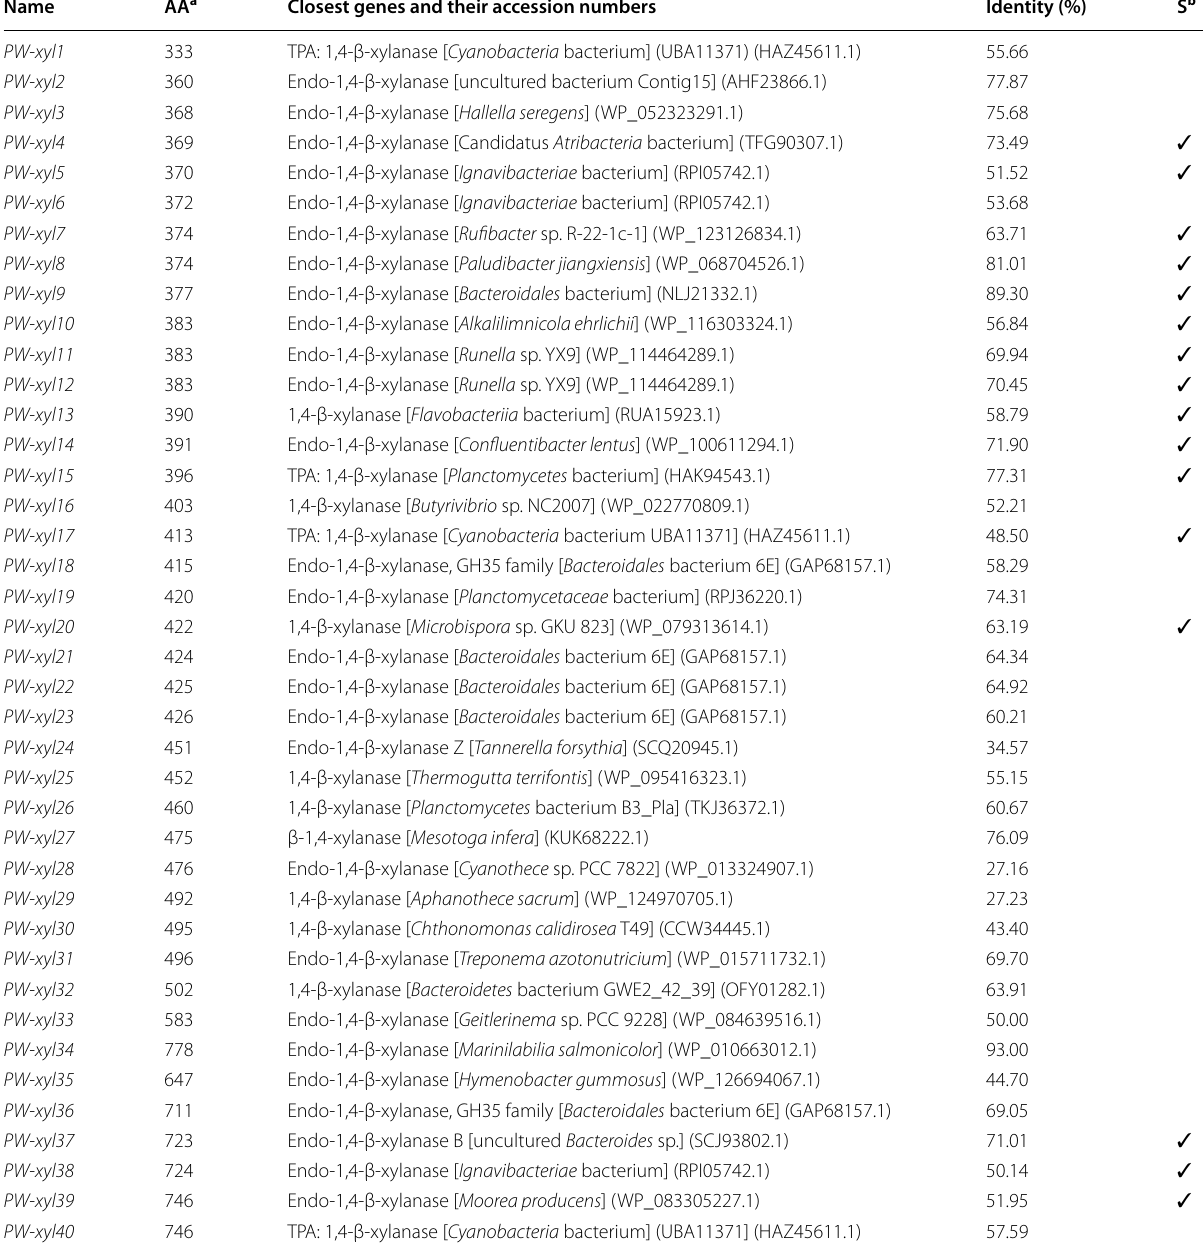
Table 1 The 40 cloned xylanase genes and their closest gene counterparts in the GenBank